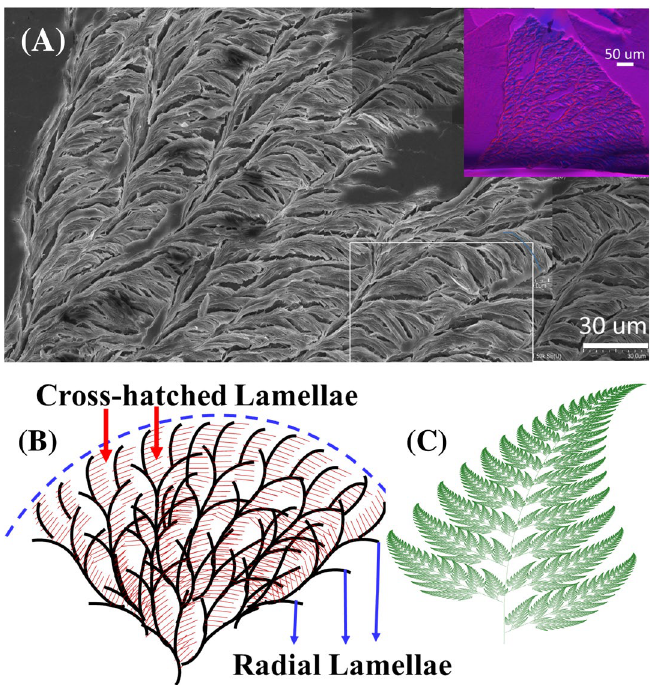
Figure 8. ( A ) SEM stacked-images for top surface of single-spoke fan in sector-face PLLA spherulites crystallized from PLLA/PMMA (80/20) blend at 115 °C; ( B ) scheme for fractal cross-hatch growth. Specimens after solvent-etching. (Inset: POM); and ( c ) fractal-growth fern-leaf (image taken from “Wikipedia”—open free source 25 ).